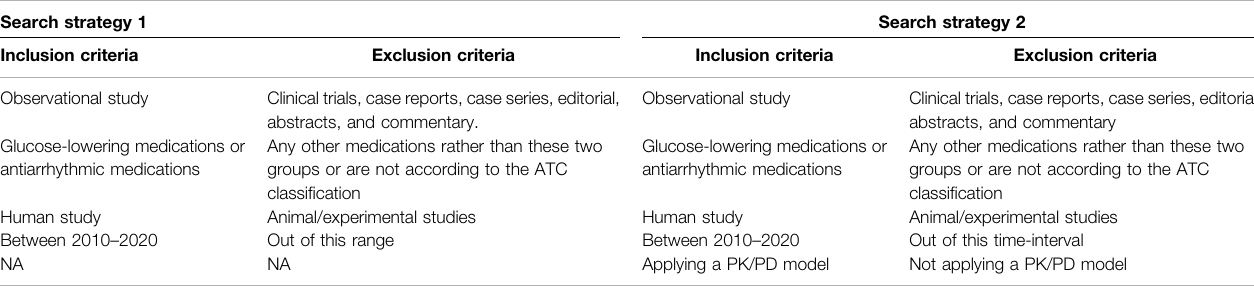
TABLE 1 | Eligibility criteria.